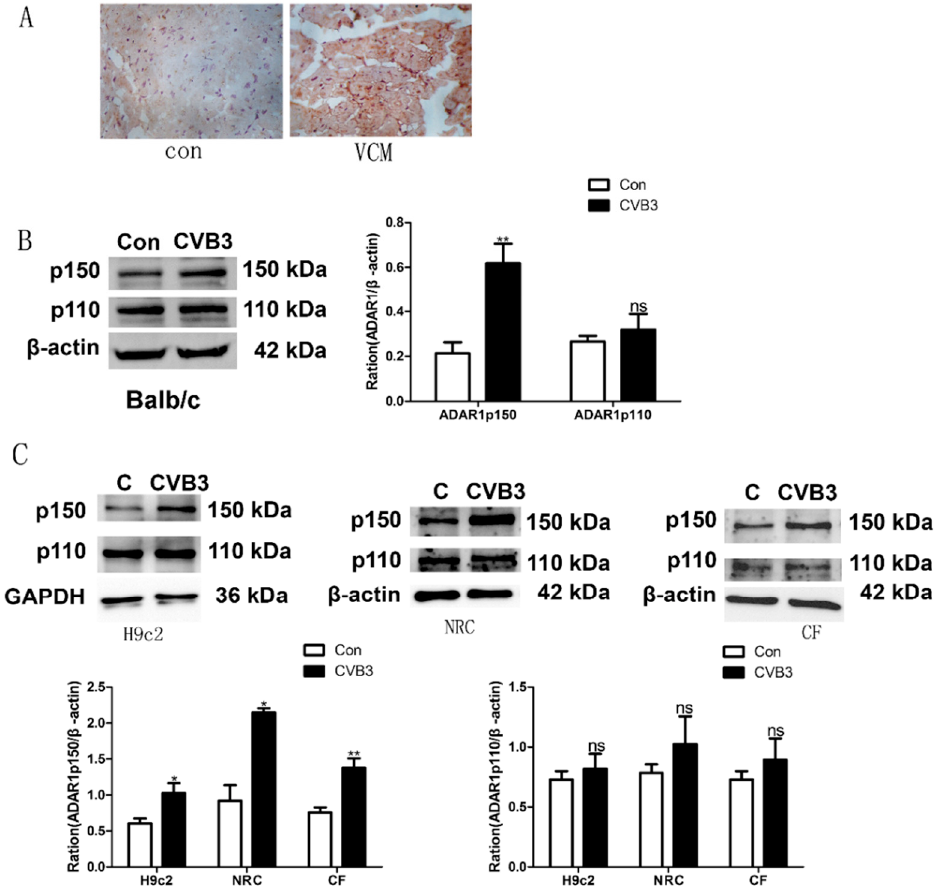
Figure 2. Adenosine deaminases acting on RNA 1 (ADAR1) expression in the hearts of VMC mice and CBV3-infected H9c2cells. ( A ) Immunohistochemical staining revealed that ADAR1 occupied the cytoplasm and its expression was increased in the cardiomyocytes from the VMC mice (original magnification 200×). ( B ) The expression of ADAR1p150 was increased in VMC (BALB/c mice) on the seventh day after infection, while ADAR1p110 was not. ( C ) The same method was used to analyze changes inADAR1 in the H9c2 cell line, primary cardiac myocytes (NRCs), and cardiac fibroblasts (CFs), respectively,48 h after CVB3 infection; the result is consistent with heart tissue. * p < 0.05, ** p < 0.01.